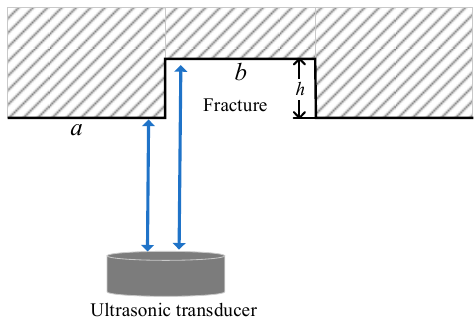
Figure 13. Schematic of the ultrasonic transducer scanning a fracture.